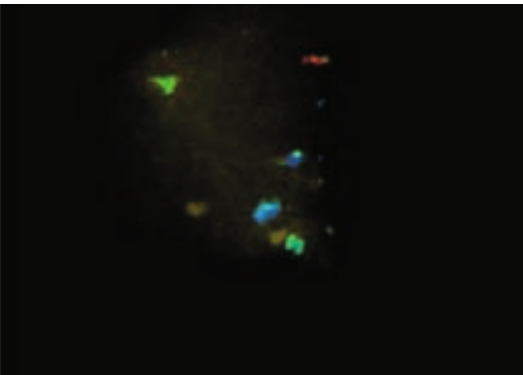
Fluorescent in-situ hybridisation of the polar body with the euploid pattern for chromosomes 13, 16, 18, 21 and